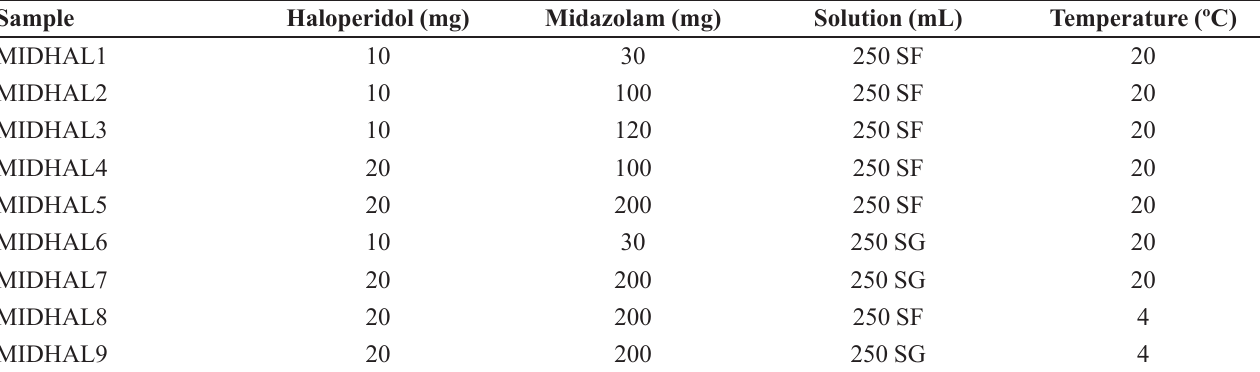
TABLE I - Midazolam/haloperidol